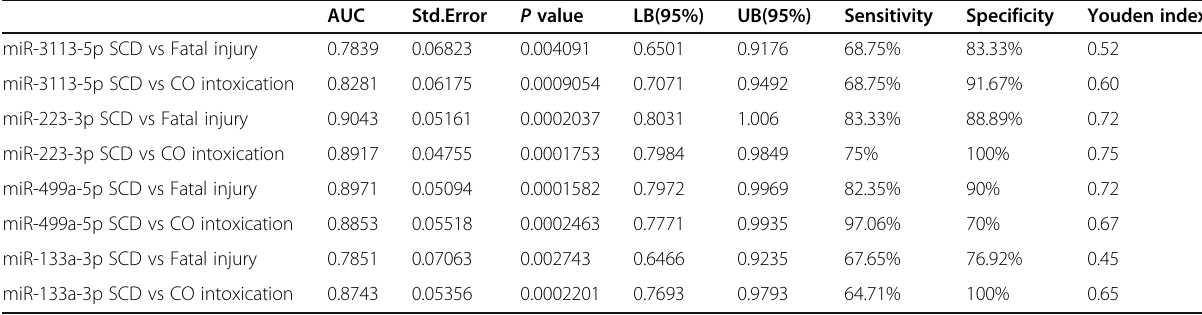
miR-133a-3p SCD vs CO intoxication 0.65 AUC Area under the curve, LB Lower bound, UB Upper